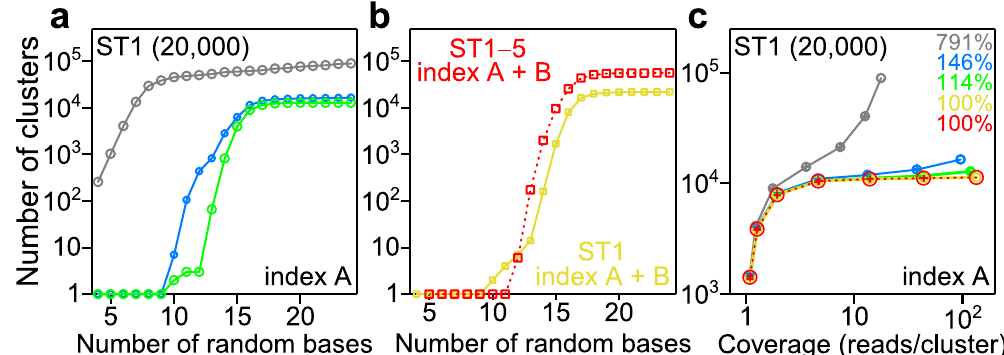
Figure 2. Observed innate characteristics of digital counting using random base barcodes applied to the two requirements for accurate digital quantification. ( a ) Dependency of the number of detected clusters (unique barcodes in gray) on the number of random bases. The results of ST1 are shown. Gray line, the number of unique barcodes; blue line, the number of observed clusters after clustering ( Distance = 3); green line, the number of clusters after clustering ( Distance = 3) and fixed base match filtering ( Fixed base number = 6). ( b ) Dependency of the number of barcode clusters on the number of random bases. Yellow line, the number of clusters for ST1 with index A and index B after clustering ( Distance = 3), fixed base match filtering ( Fixed base number = 6); red dotted line, the number of barcode clusters for all short templates with index A and index B after clustering ( Distance = 3), fixed base match filtering ( Fixed base number = 6). ( c ) Dependency of the number of detected clusters on the sequencing coverage. The gray, blue, and green are the same as in (a). Yellow line, the number of clusters for ST1 with index A after clustering ( Distance = 3), fixed base match filtering ( Fixed base number = 6), and removing contaminated indices; red dotted line, the number of barcode clusters for ST1 with index A after clustering ( Distance = 3), fixed base match filtering ( Fixed base number = 6) and removing contaminated indices and misidentification (see Methods). Colored percentages indicate the number of clusters relative to the red at the highest coverage. Error bars represent standard deviation (n =